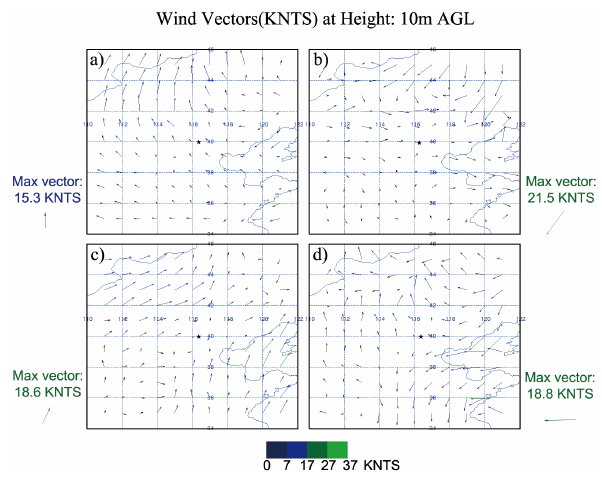
Figure 10. Wind field graphs of the NCP at (a) 02:00 LST 10 Octo- ber, (b) 02:00 LST 20 October, (c) 02:00 LST 24 October, and (d) 02:00 LST 31 October; black star denotes Beijing city, the color bar represents wind